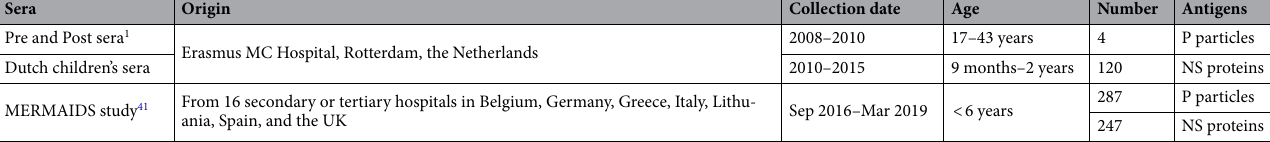
Table 3. Summary of sera used. 1 RT-PCR confirmed norovirus infection with GI.1, GII.3, or GII.4 (Den Haag 2006b or New Orleans